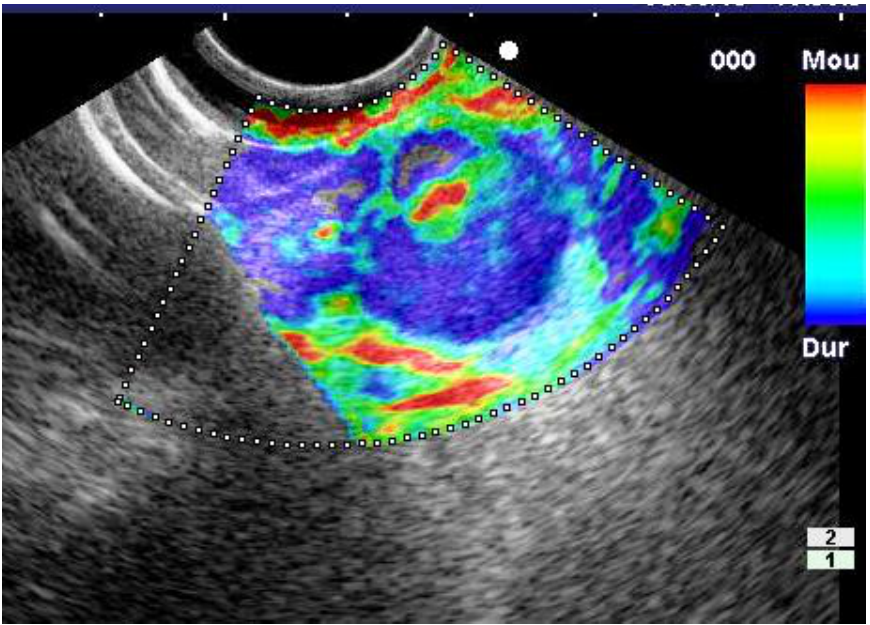
FIGURE 14. Score 4: malignant endocrine tumor of the head of pancreas.